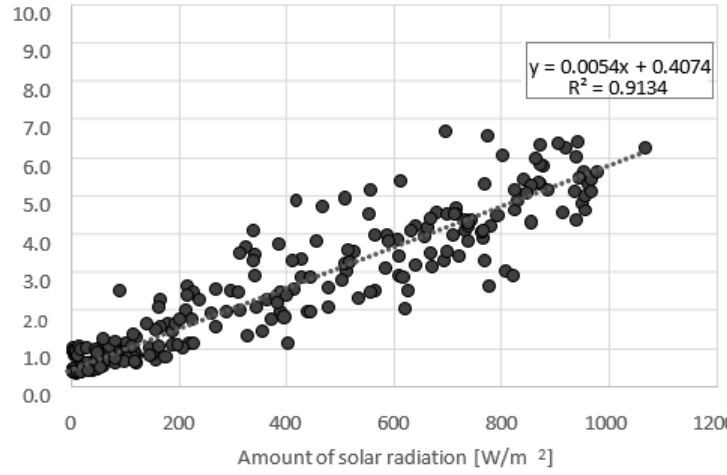
Figure 8. Relationship between insolation and outlet temperature rise.